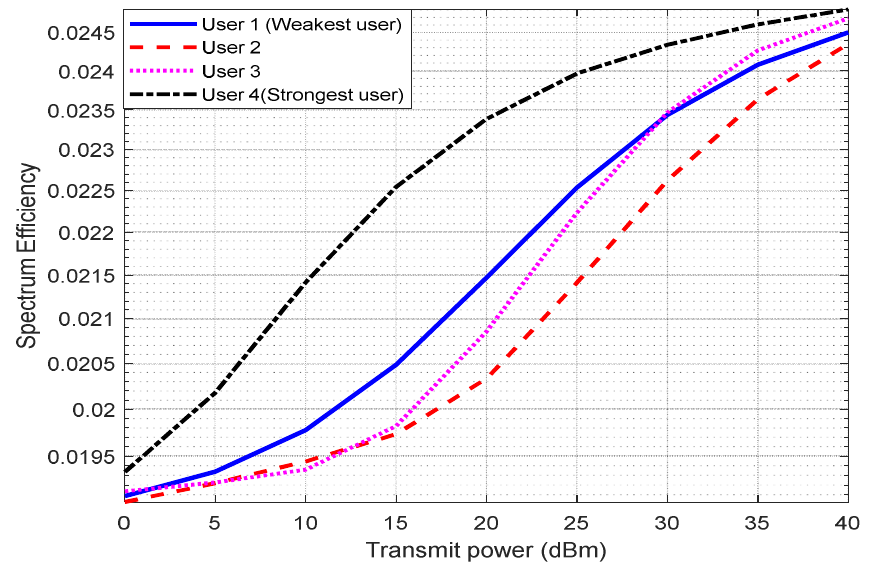
Figure 7. SE vs. transmit power for four users with varying distances, with power coefficients and BW 80 MHz for DL NOMA.